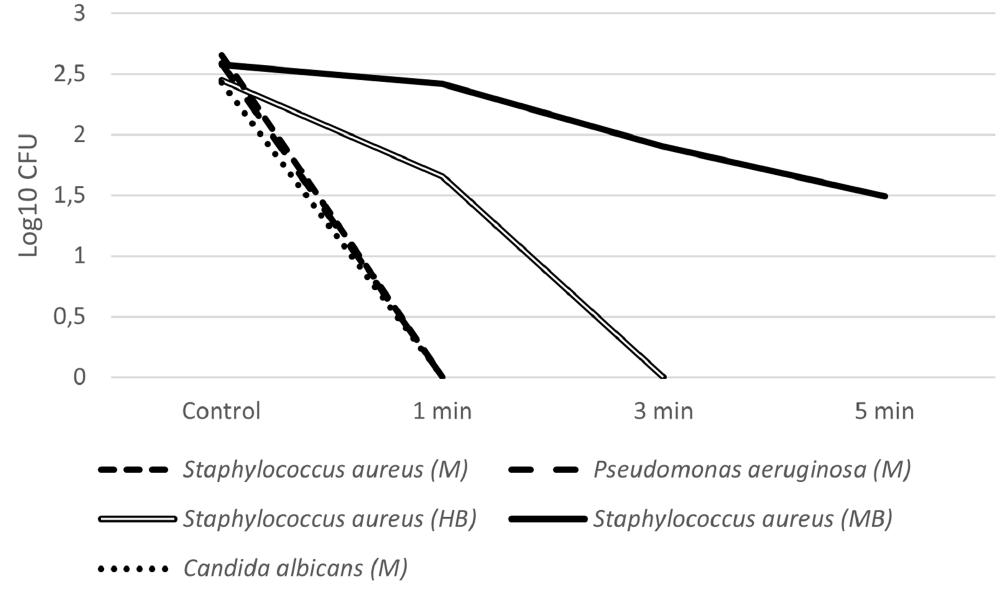
Figure 2. Average CFU count (Log CFU) of the microorganisms tested ( S. aureus, P. aeruginosa , and 10 C. albicans ) after exposure to UV-C light according to the tested times (control, 1 min, 3 min, and 5 min). M: face mask, HB: hairbrush, MB: makeup brush.